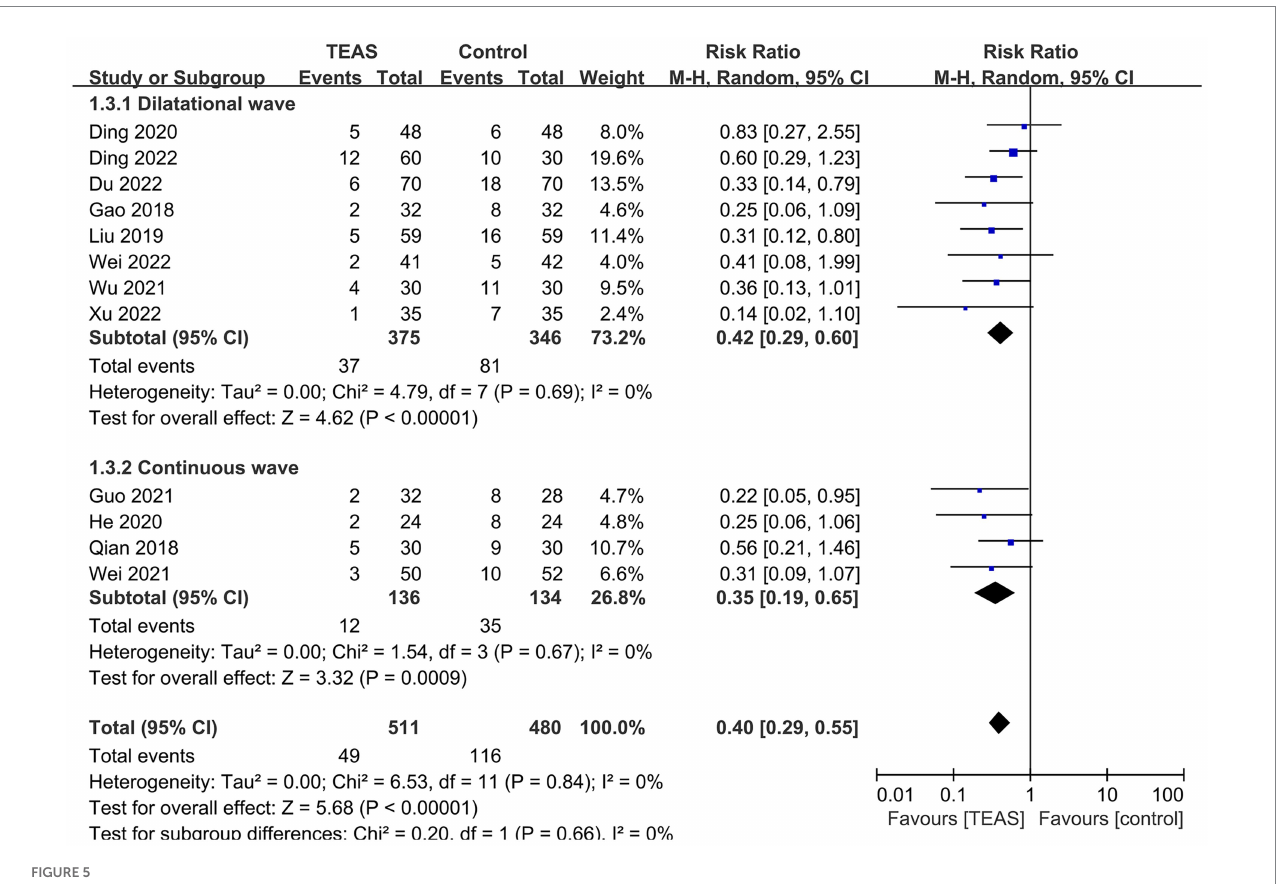
FIGURE 5 Subgroup analysis of the incidence of POD based on different TEAS